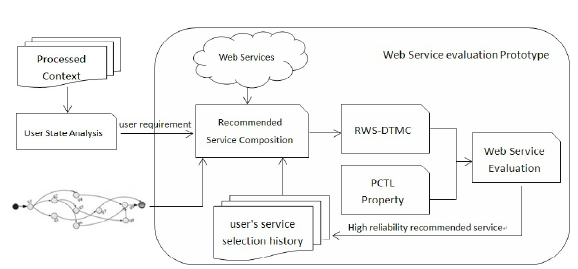
Fig. 1. Web service evaluation prototype